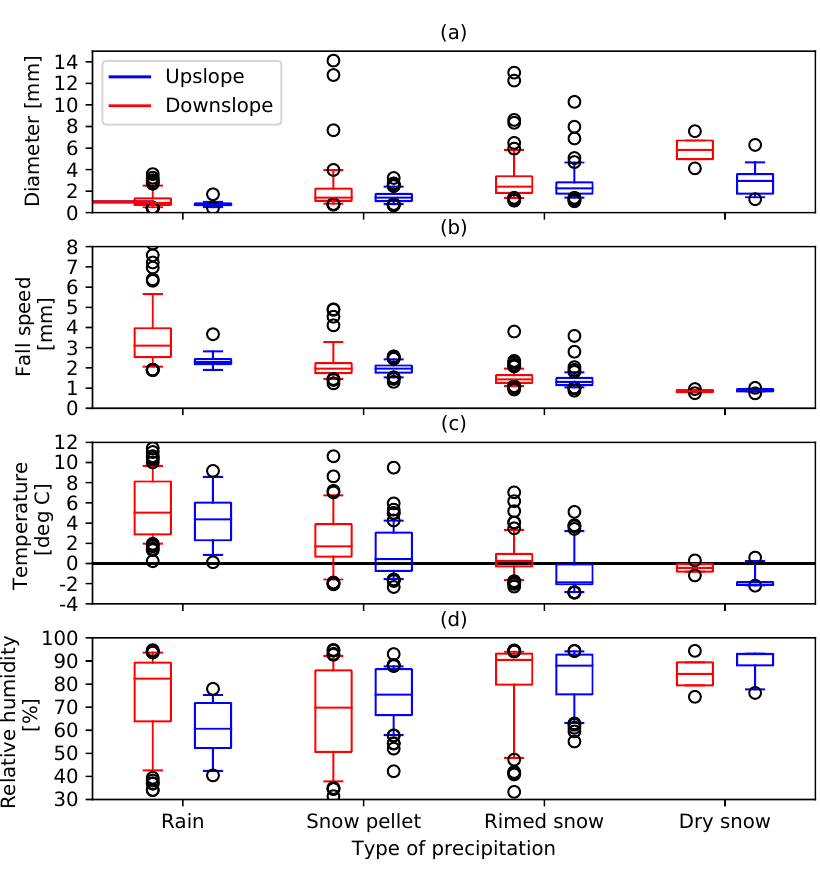
Figure 10. Comparison of the surface conditions associated with the four main types of precipitation over the March–April 2015 period. The main types are rain ( R ), snow pellets (SP), rimed (RS) and dry snow (DS), and these are shown occurring during westerly (red) and easterly (blue) flow events. (a) is the diameter, (b) the fall speed, (c) the air temperature and (d) the relative humidity. The red line is the median, the box is between the 25th and 75th percentiles, and the whiskers are the 5th and 95th